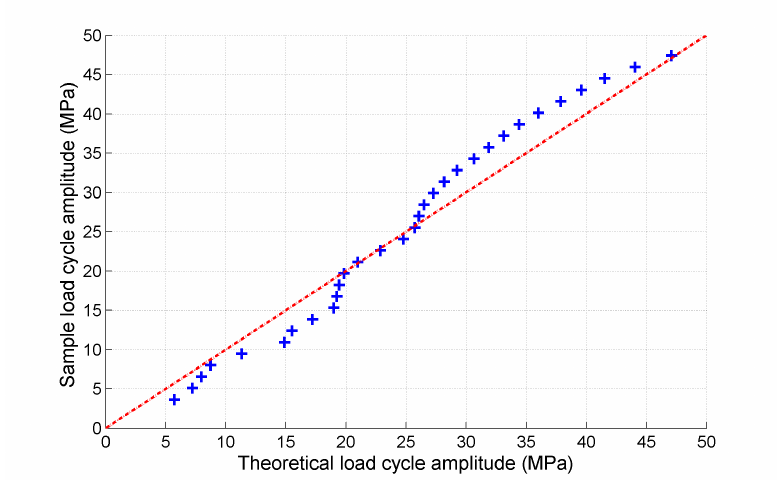
Figure 10. Example of the Q-Q (quantity-quantity) plot of a surface stress cycle Weibull distribution fit to the load cycle for one segment ( D = 80